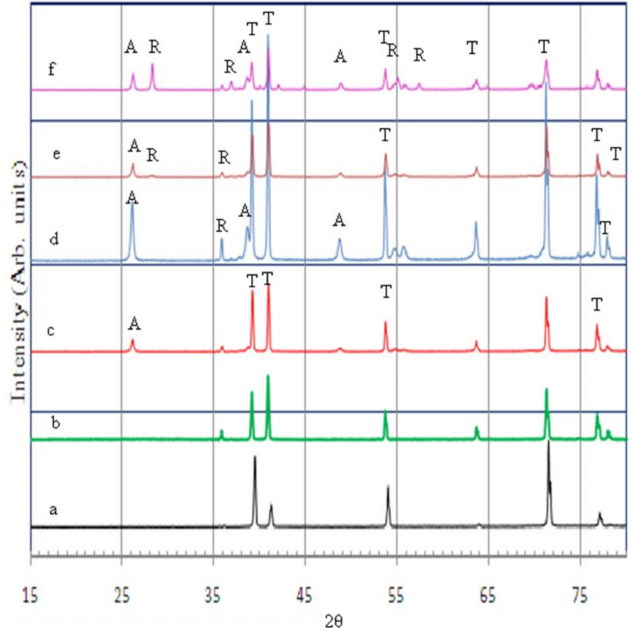
Figure 3. X-ray diffraction patterns for ( a ) Ti-metal foil; ( b ) as-anodized TNTAs; ( c ) TNTAs annealed at: 350 ◦ C; ( d ) 450 ◦ C; ( e ) 550 ◦ C and ( f ) 650 ◦ C, all for 3 h in